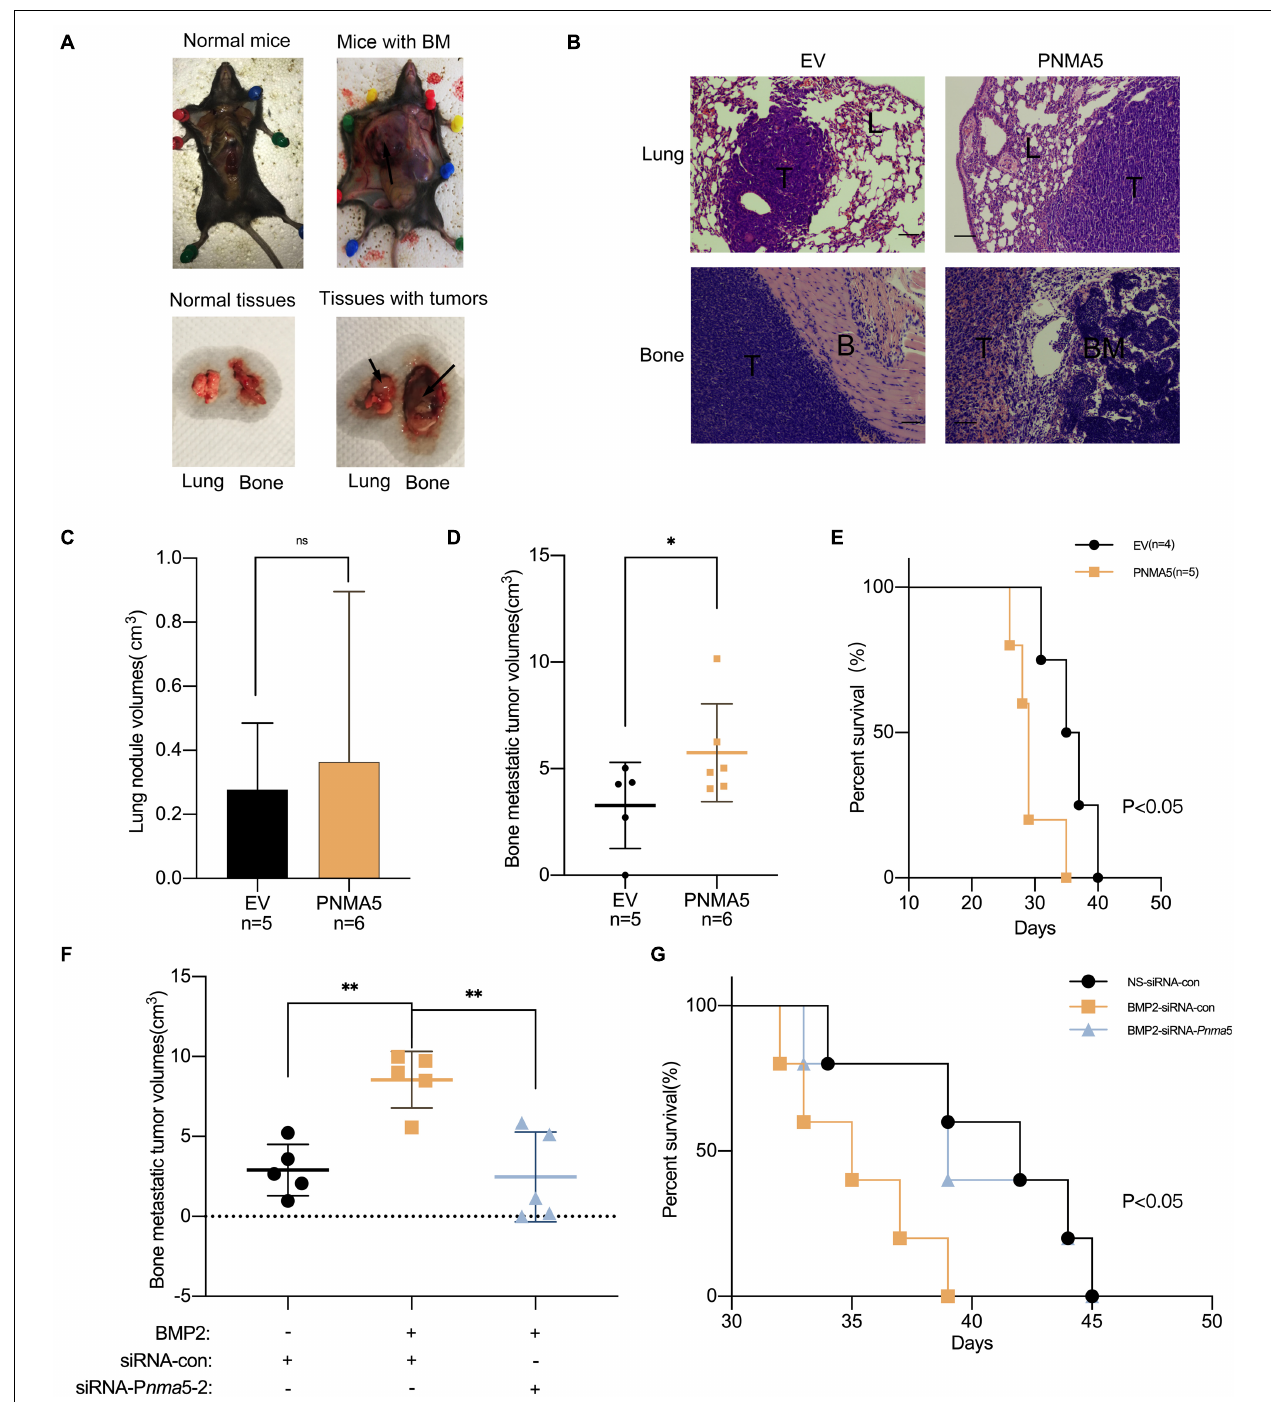
FIGURE 6 | BMP2 signaling enhanced bone metastasis of Lewis lung carcinoma via PNMA5 in vivo . (A) 1 × 10 6 empty vector (EV) and PNMA5 overexpressed LLC cells were injected into the left lung lobes of C57BL/6 mice. Graphs of tumor-burdened mice were shown. Black arrows showed the bone metastatic lesions. Normal and tumor burdened lung and bone tissues were shown. Black arrows showed the metastatic lesions. BM: metastatic bone tumors. (B) Representative HE staining of tissues from lungs and bones in (A) . Scale bars of the 100 × photos were 100 µ M. L, normal lung tissues; T, tumor tissues; B, normal bone tissues; BM, normal bone marrow tissues. (C) Tumor sizes of mice lungs in (A) were measured and tumor volumes were calculated. (D) Tumor sizes of mice bones in (A) were measured and tumor volumes were calculated. * P < 0.05. (E) Death of mice in (A) were recorded and survival curves were drawn. * P < 0.05. (F) 1 × 10 6 siRNA scrambler, siRNA Pnma5 -1 and siRNA Pnma5 -2 expressed LLC cells were injected into the left lung lobes of C57BL/6 mice. Tumor sizes of mice bones in (A) were measured and tumor volumes were calculated. ** P < 0.01. (G) Death of mice in (F) were recorded and survival curves were drawn. * P < 0.05.